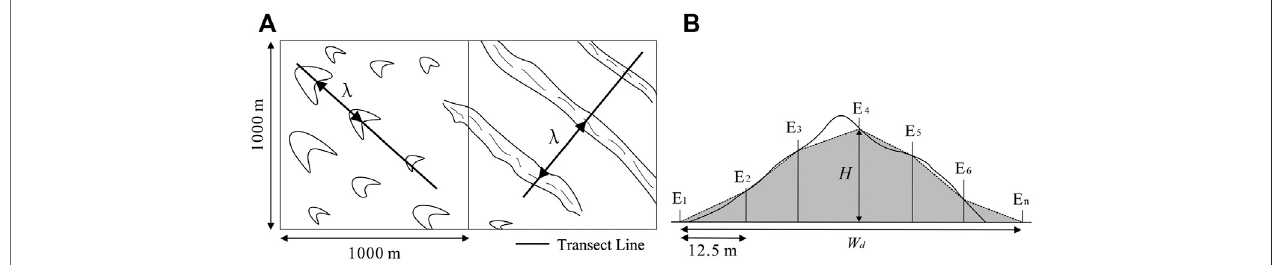
FIGURE3|(A) Orientationofthetwo-dimensionaltransectsforthetwodunetypes(where λ representsthedunespacingbetweencrests)and (B) thedunecross- sectional pro fi le, indicating the distribution of the DEM elevation points. E 1 to E n represent sampling positions. H is the height of the dune ’ s crest and W d is the distance between adjacent interdune areas. Source: adapted from Bullard et al. (2011).